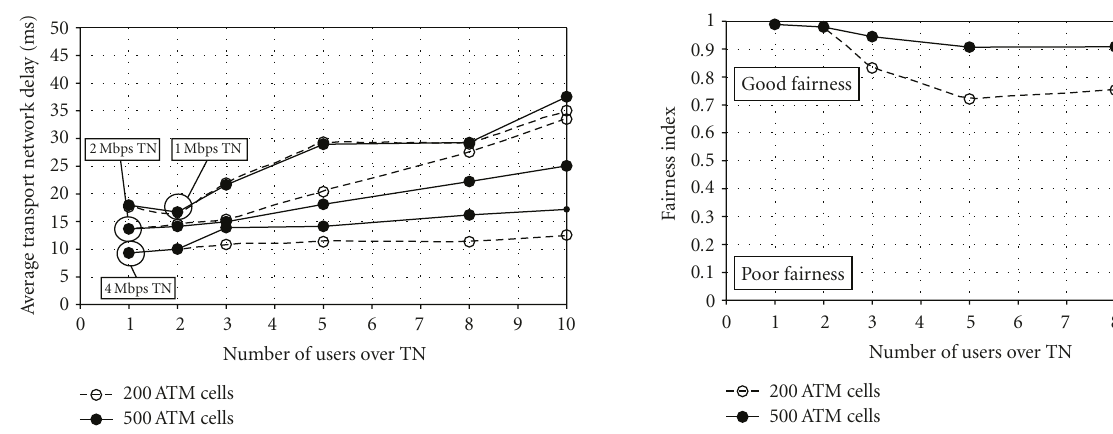
Figure 10: Jain’s fairness index in case of 4 Mbps TN. Table 1: TN bu ff er size for di ff erent TN